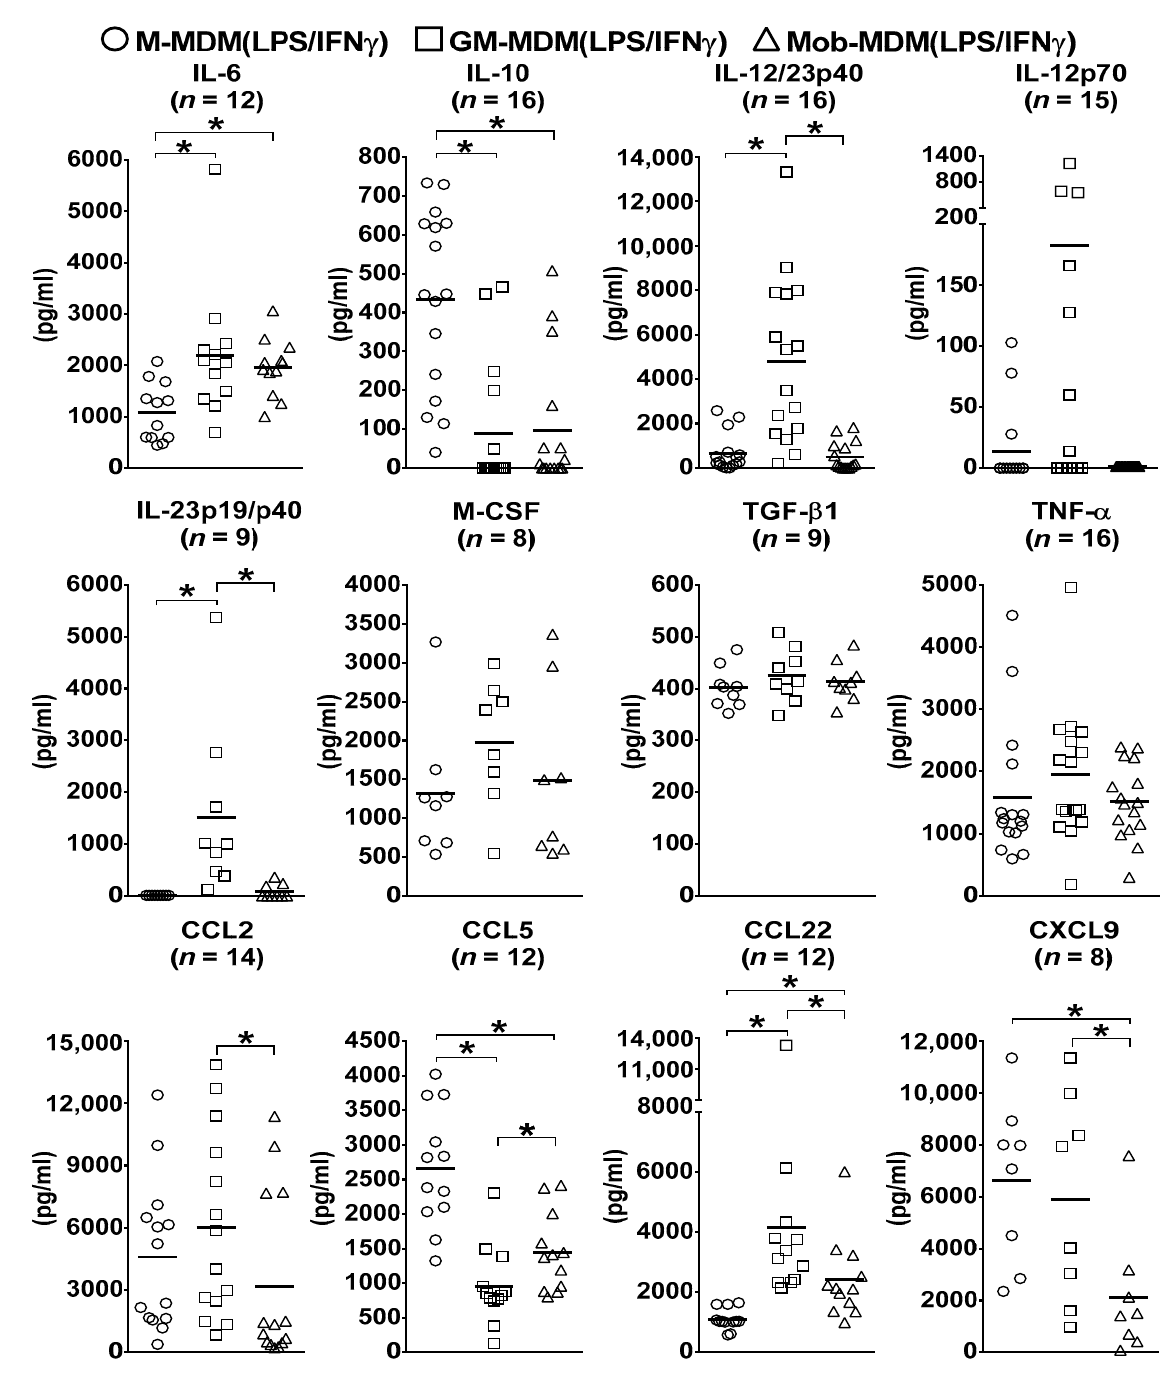
Figure 1. Cytokine and chemokine secretion by lipopolysaccharide (LPS)/interferon γ (IFN γ )-activated monocyte-derived macrophages (MDMs). Macrophage colony-stimulating factor MDMs (M-MDMs), granulocyte/macrophage colony-stimulating factor MDMs (GM-MDM), and heat-killed Mycobacterium obuense MDMs (Mob-MDMs) were generated and activated with LPS and IFN γ for 24 h as described below (see the Materials and Methods section (Section 4)). Cytokine and chemokine levels were determined in M-MDM(LPS/IFN γ ), GM-MDM(LPS/IFN γ ), and Mob-MDM(LPS/IFN γ ) culture supernatants by ELISA. Scatter plots demonstrate chemokine or cytokine concentration (pg/mL) in different LPS/IFN γ -activated MDM culture supernatants. Horizontal bars indicate group mean values of cytokine or chemokine concentration of at least 8 independent donors. One-way ANOVA, followed by Tukey’s post-hoc test, was performed to determine statistically significant differences in cytokine/chemokine secreted levels (* p < 0.05). Circles represent M-MDM(LPS/IFN γ ), squares represent GM-MDM(LPS/IFN γ ) and triangles represent Mob-MDM(LPS/IFN γ ).